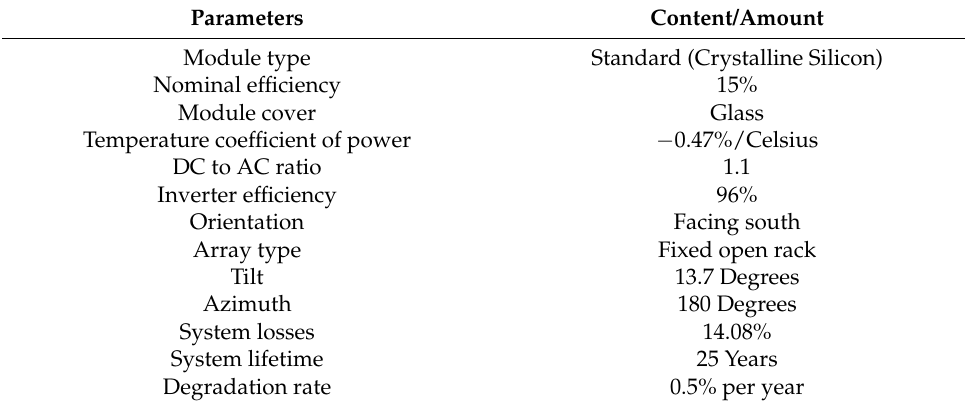
Table A3. Technical assumptions.